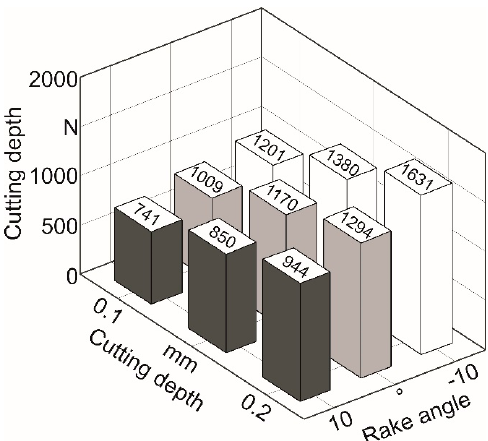
Figure 3. Plot of cutting force for different cutting depths and rake angles in the machining of Ti-1023 titanium alloy.